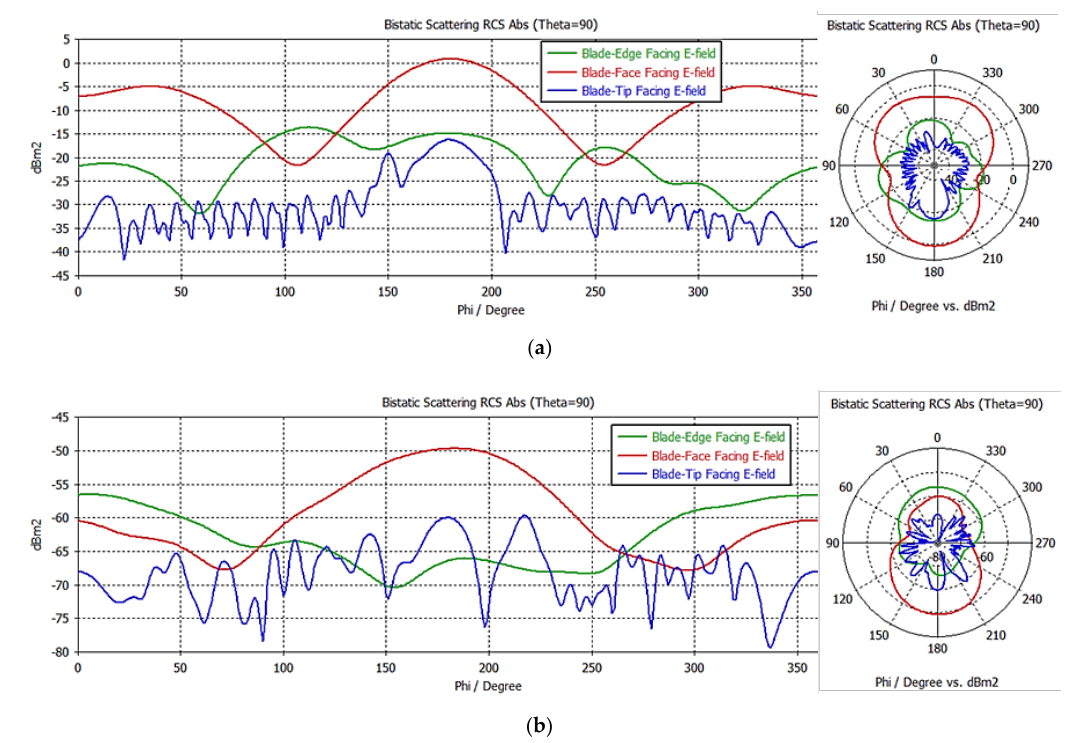
Figure 3. Drone blade’s RCS in Cartesian and Polar coordinates at three different blade orientations for ( a ) PEC and ( b ) Plastic. Table 4. Cartesian and Polar summary of values for plastic and PEC